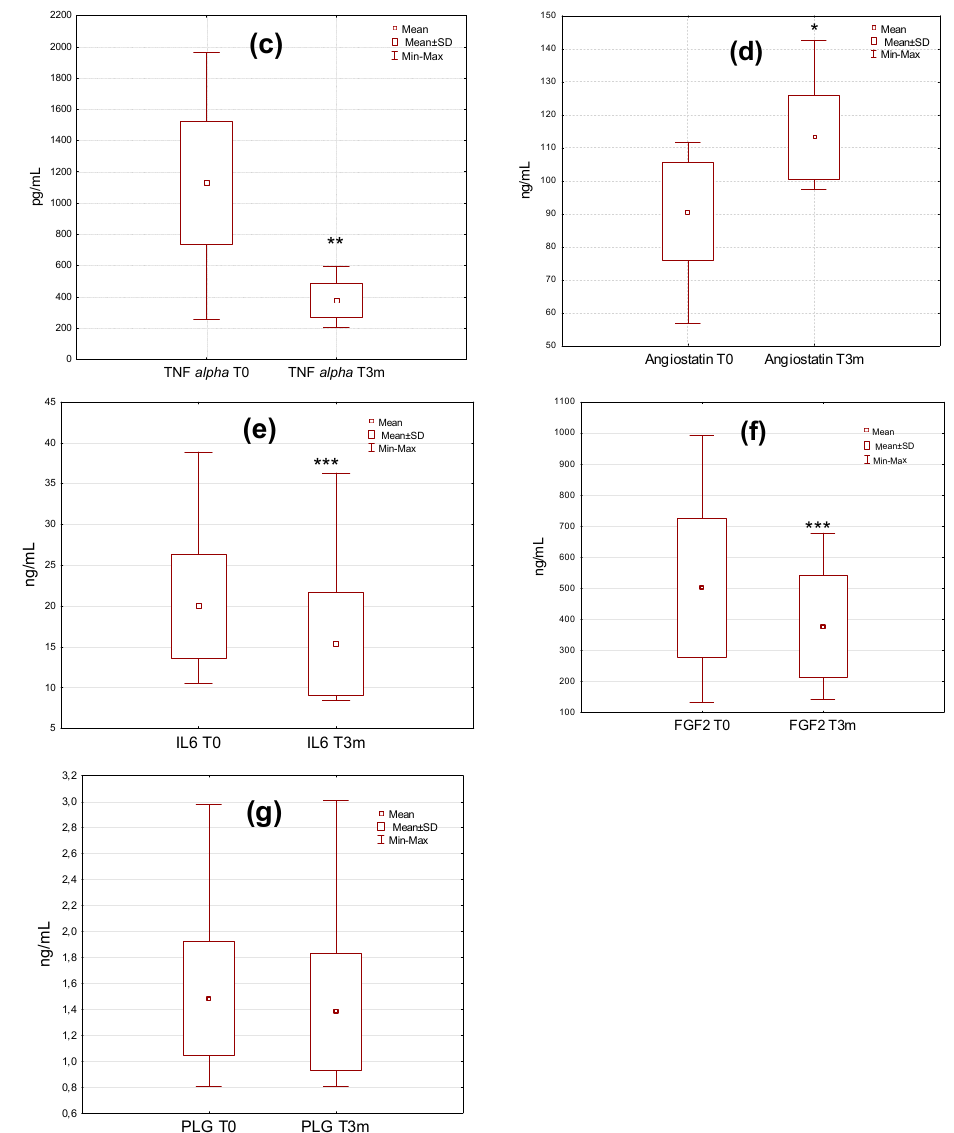
Figure 2. Plasma level of VEGF-A ( a ), VEGF-C ( b ), TNF alpha ( c ), angiostatin ( d ), IL6 ( e ), FGF2 ( f ) and plasminogen ( g ) before (T0) and after three months (T3m) of diosmin treatment. * p < 0.05, ** p < 0.001, and *** p < 0.01 .